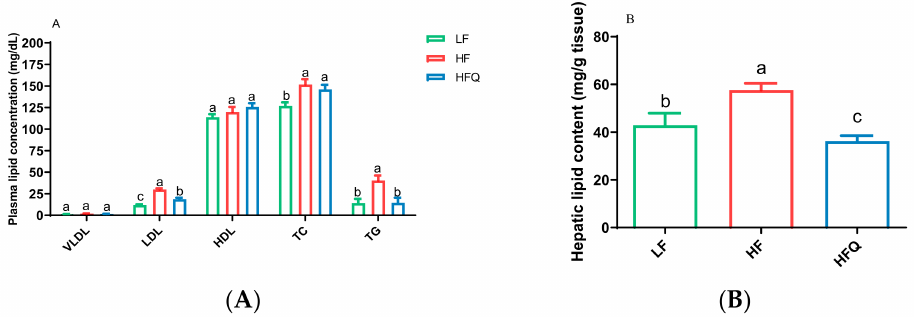
Figure 2. ( A ). Plasma lipoprotein cholesterol concentration and triglyceride level in mice fed a high-fat (HF) diet, high-fat diet containing 0.05% quercetin (HFQ), and low-fat (LF) diet for 6 weeks. VLDL: very-low-density lipoprotein; LDL: low-density lipoprotein; HDL: high-density lipoprotein; TC: total cholesterol; TG: triglyceride. Data are expressed as means ± SEMs, n = 8/group. Bars with different letters within the same plasma lipoprotein were significantly different ( p < 0.05). ( B ). Hepatic total lipid content in mice fed with high-fat (HF) diet, high-fat diet containing 0.05% quercetin (HFQ), and low-fat (LF) diet for 6 weeks. Data are expressed as means ± SEMs, n = 5/group. Bars with different letters were significantly different ( p <